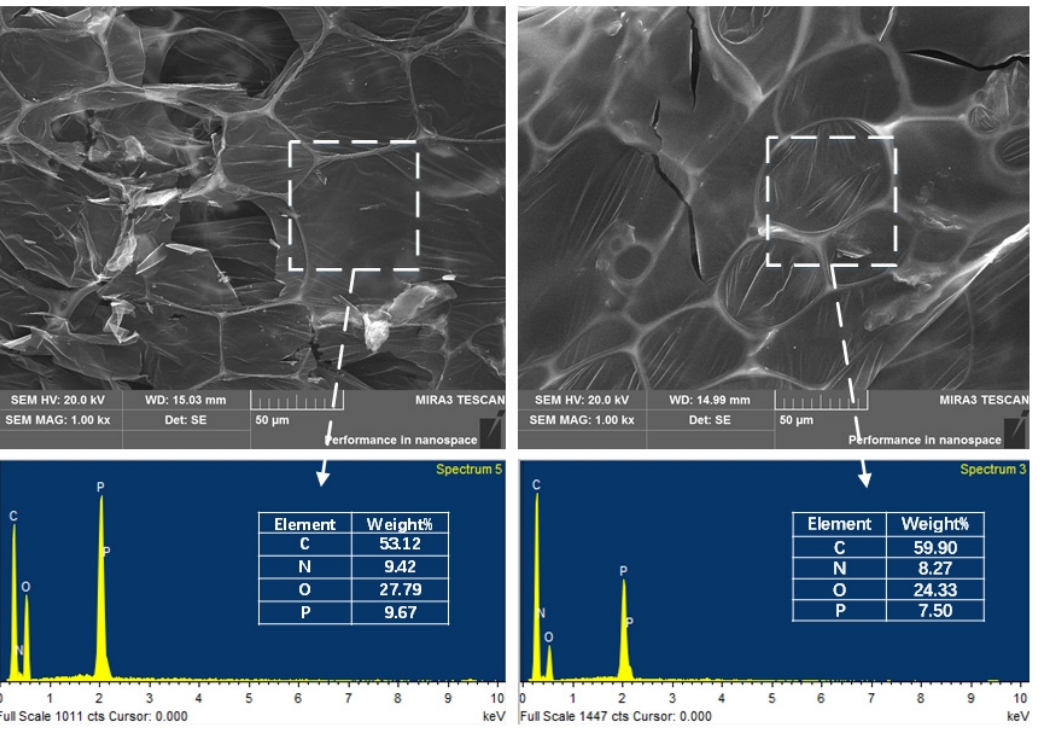
Figure 10. SEM images and EDS maps of the char residues of EP/15RGO@APP ( left ) and EP/15RGO- APP ( right ) were obtained after the cone calorimeter test.